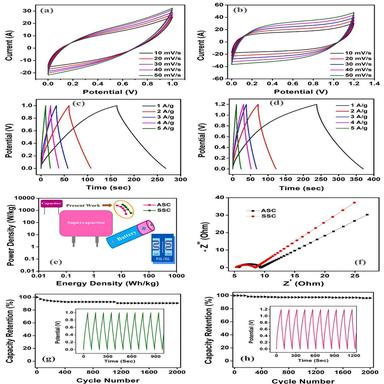
(a-b) CV curves at different scan rates (10–50 mV/s), (c-d) GCD curves at different current densities (1–5 A/g), (e) Ragone plot, (f) Nyquist plots, (g-h) cyclic stabilities (inserted image shows the first ten charge-discharge cycles) of the BiOBr/g-C3N4||g-C3N4 asymmetric (ASC) and BiOBr/g-C3N4||BiOBr/g-C3N4 symmetric (SSC) supercapattery devices respectively.